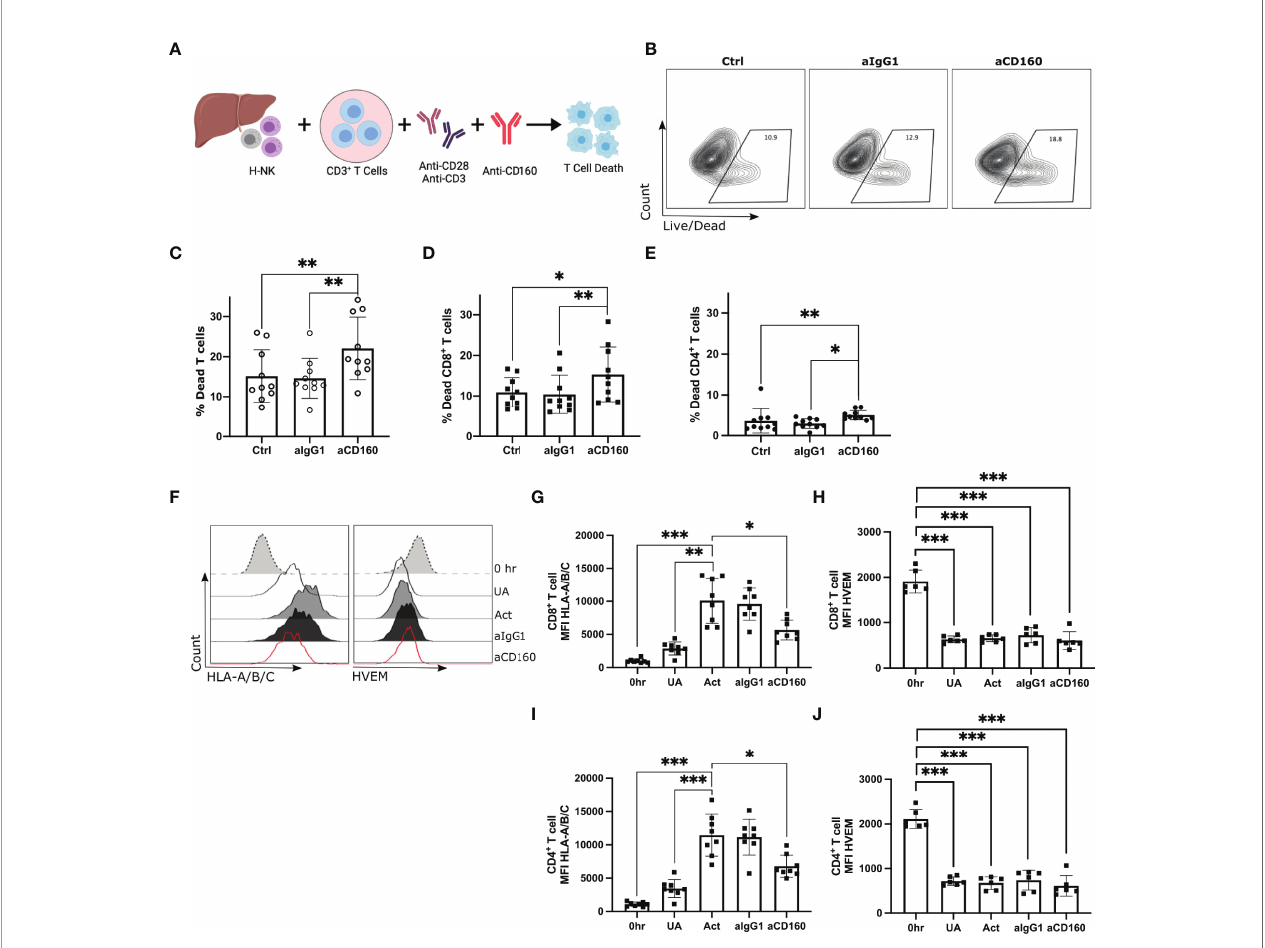
FIGURE 4 | CD160 engagement on hepatic NK cells enhances killing of allogenic CD8 + T cells. Activated CD3 + T cells co-cultured with H-NK cells with or without a mAb against CD160 for 24 hr (n = 13). (A), Schematic of experimental design. (B) , Representative fl ow plots of the percent dead total T cells in each treatment group. ‘ Ctrl ’ indicates cocultures of CD3 + T cells with H-NK cells without the addition of any antibody. ‘ aIgG1 ’ indicates cocultures of CD3 + T cells with H-NK cells with the addition of an IgG1 antibody. ‘ aCD160 ’ indicates cocultures of CD3 + T cells with H-NK cells with the addition of an anti-CD160 mAb. (C – E) , Percent dead total T cells (C) , CD8 + T cells (D) and CD4 + T cells (E) following 24 hr co-culture of CD3 + T cells with hepatic NK cells. (F), Representative fl ow plots of HLA-A/B/C and HVEM MFI of CD8+ T cells at 0 hr and for each treatment at 24 hr. (G, H) , MFI values for HLA-A/B/C (G) and HVEM (H) on CD8 + T cells and CD4 + T cells at 0 hr and for each treatment group at 24 hr. Data analysed using a Freidman test with Dunn ’ s multiple comparison (C – E) or a repeated measures one-way ANOVA (G – J) . *p < 0.05, ** p < 0.01, and ***p <